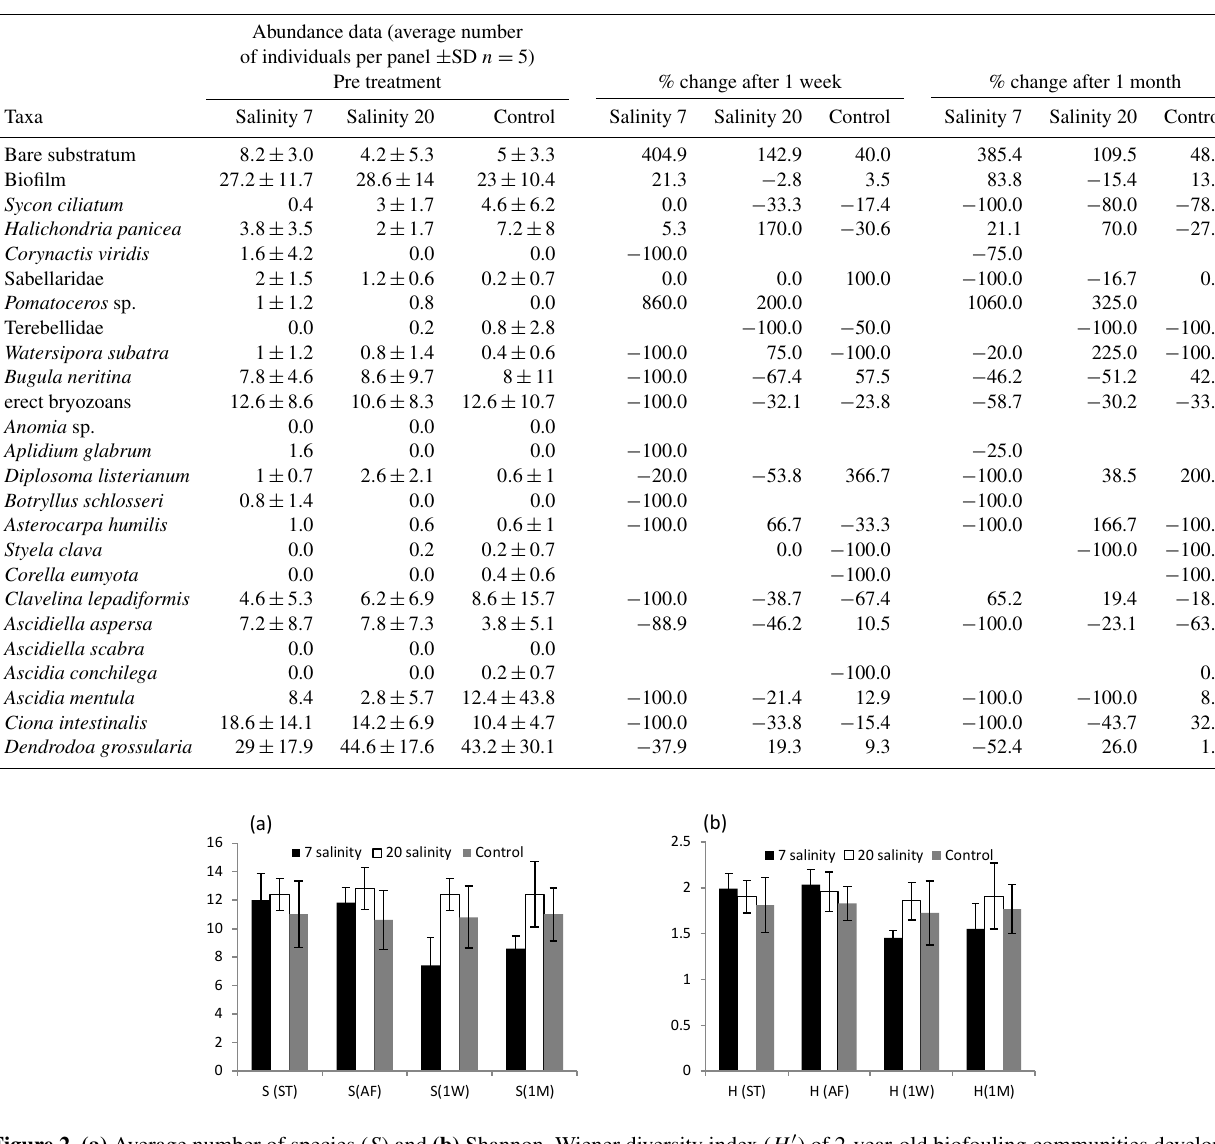
Table 1. Average number of biofouling individuals per panel subjected to treatment with salinities of 7, 20 and 33 (control), showing % change in abundance after 1 week and after 1 month.